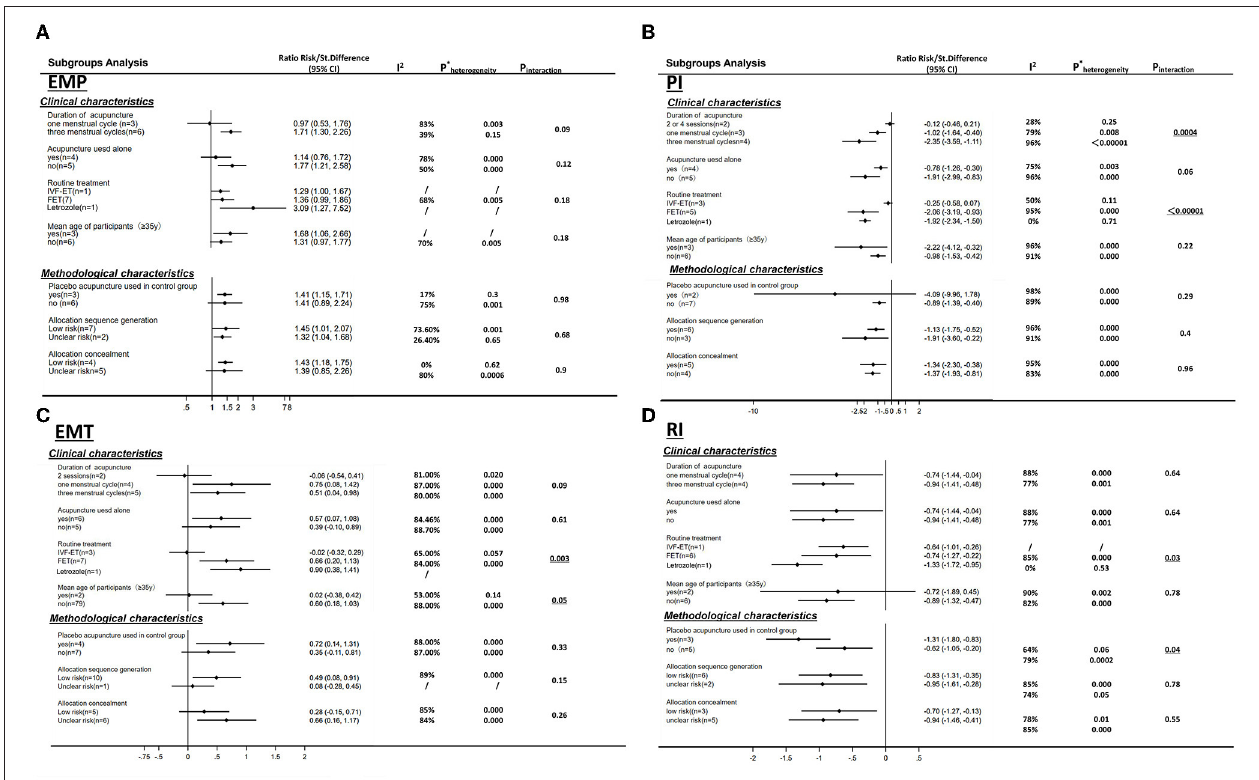
FIGURE 11 | Heterogeneity analysis of four endometrial receptivity characteristics by seven variables. (A) endometrial pattern; (B) pulse index; (C) endometrial thickness; (D) resistance index. Seven variables including four clinical characteristics. Acupuncture duration, intervention of different routine treatment (IVF-ET, FET or clomiphene for ovulation induction), acupuncture used alone or with other interventions and mean age of participants ( ≥ 35y or not) and three methodological characteristics blinding of participants (sham/placebo or no adjuvant treatment); random sequence generation (adequate or not); allocation concealment (adequate or not) (*:0.000 of P heterogeneity means